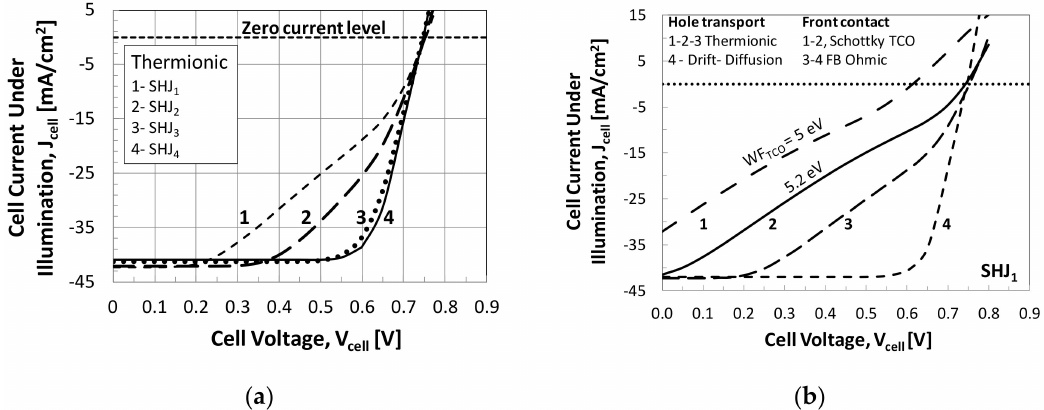
Figure 4. ( a ) Simulated I-V characteristics under illumination at 300 K assuming thermionic emission transport for cells SHJ 1 (N a-Si = 5 × 10 18 cm − 3 ), SHJ 2 (N a-Si = 10 19 cm − 3 ), SHJ 3 (N a-Si = 5 × 10 19 cm − 3 ), and SHJ 4 (N a-Si = 1 × 10 20 cm − 3 ) [35]. ( b ) Simulated I-V characteristics under illumination at 300K for cell SHJ 1 with N a-Si = 5 × 10 18 cm − 3 : Thermionic emission transport (Curves 1, 2, and 3), drift-diffusion transport (Curve 4). Front contact: WF TCO = 5 eV (Curve 1) and 5.2 eV (Curve 2), flat band (Curves 3 and